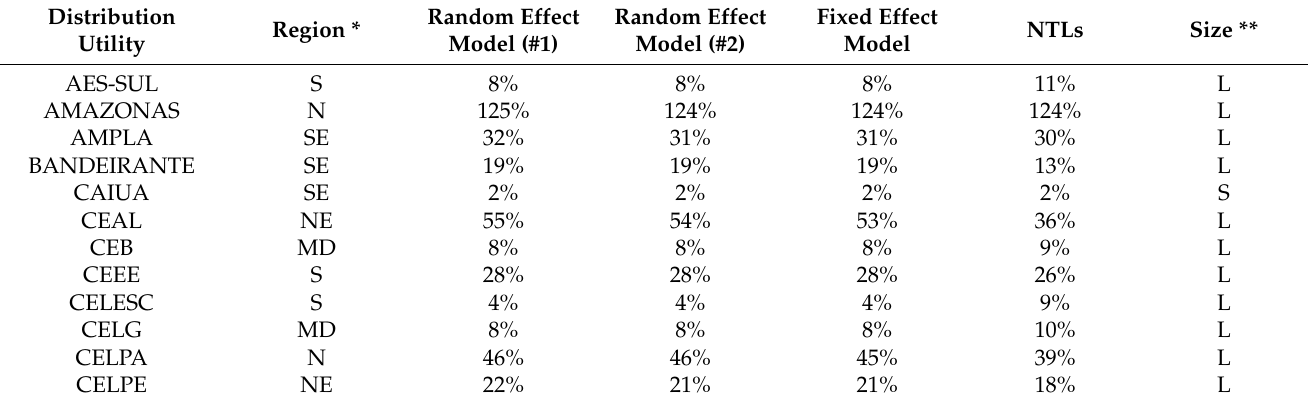
Table 7. Predictive result of electricity distribution